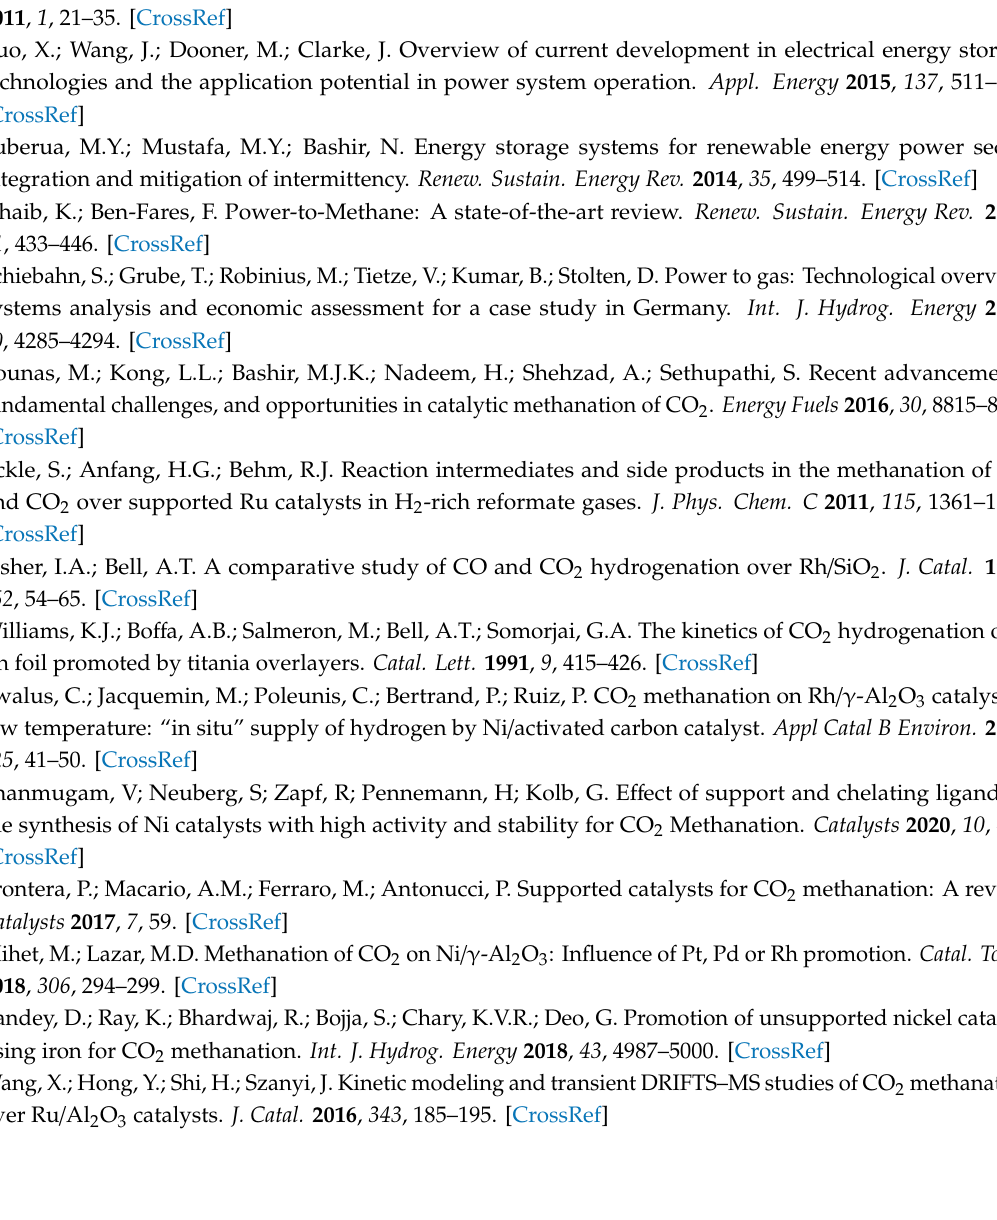
Figure S1: Time on stream measured CO 2 methanation performance as functions of the Ru loading and reaction temperature. (a) CO 2 conversion, (b) H 2 e ffi ciency, (c) CH 4 selectivity, (d) CO selectivity, (e) CH 4 yield, and (f) CO yield. Figure S2: Time on stream measured CO 2 methanation performance as functions of the Ru-Ni catalysts and reaction temperature. (a) CO 2 conversion, (b) H 2 e ffi ciency, (c) CH 4 selectivity, (d) CO selectivity, (e) CH 4 yield, and (f) CO yield. Figure S3: Time on stream measured thermal stability test of 1wt% Ru-10wt% Ni / Al 2 O 3 catalyst under three continuous ascending-descending temperature change cycles between 250 and 550 ◦ C. (a) CO 2 conversion, (b) H 2 e ffi ciency, (c) CH 4 selectivity, (d) CO selectivity, (e) CH 4 yield, and (f) CO